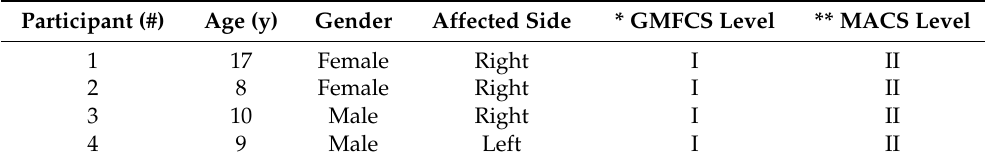
Table 4. Demographic information about participants recruited for